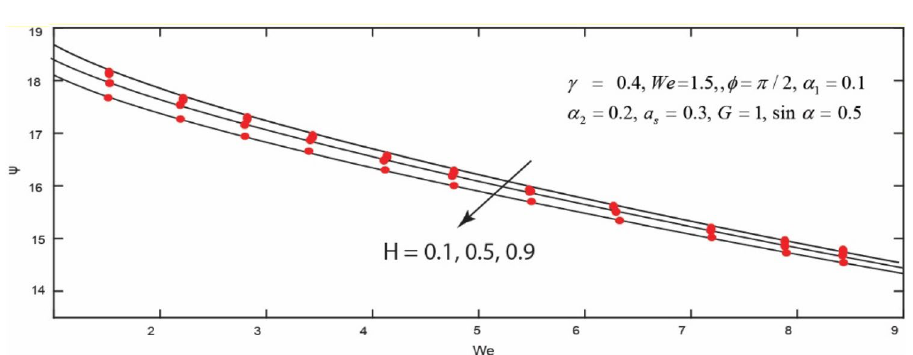
Figure 9. Impact of H on power transferred by swimmers.